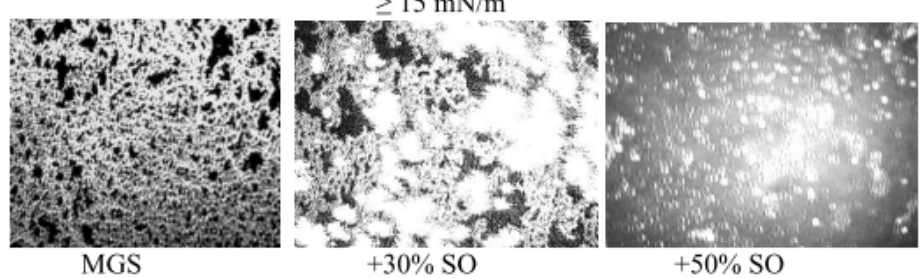
Figure 5. Thickening of MGS films via supplementation with SO (brightness of the images is attenuated to ensure visibility) (micrograph size is 500 µ m × 300 µ m).